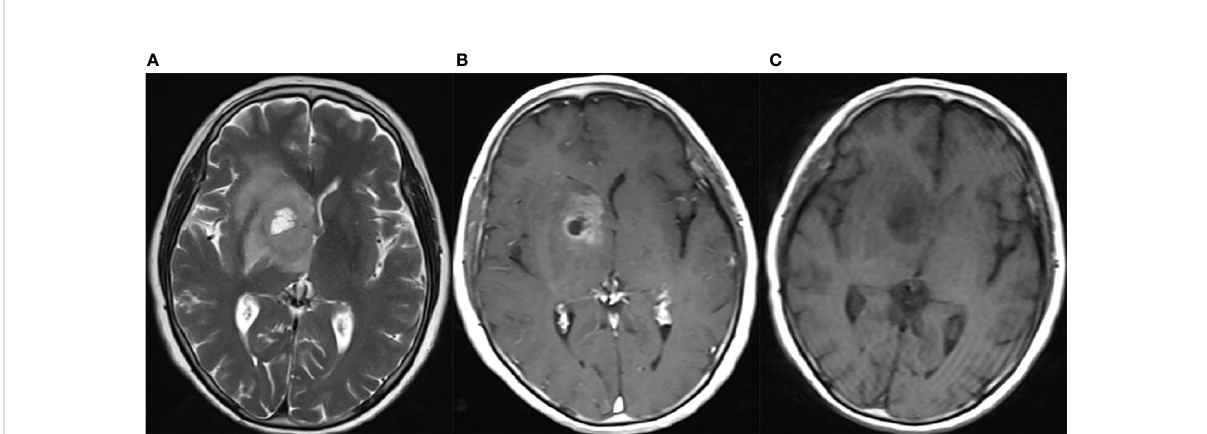
FIGURE 1 Neuroradiological fi ndings for eGBM case 11. Neuroradiological results for eGBM case 11. (A) A heterogeneous lesion with necrosis and perilesional oedema on T1 in the right basal ganglia with signi fi cant midline shift, 23 mm × 28 mm × 17 mm in size. (B) A heterogeneous lesion with perilesional oedema (T2). (C) A rim-enhancing mass with perilesional oedema (T1-weighted